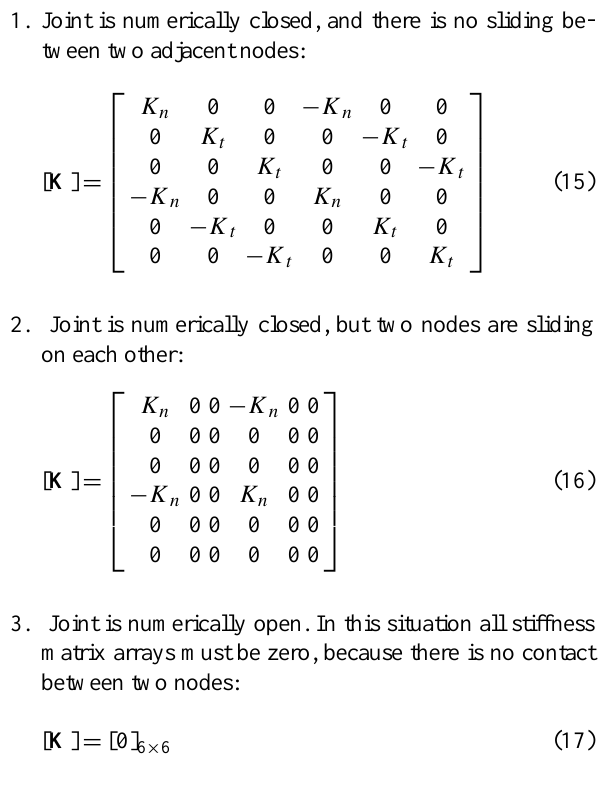
Fig. 10. Normalized shear modulus-shear strain and damping ratio relationships for rocks (Schnabel et al., 1972).